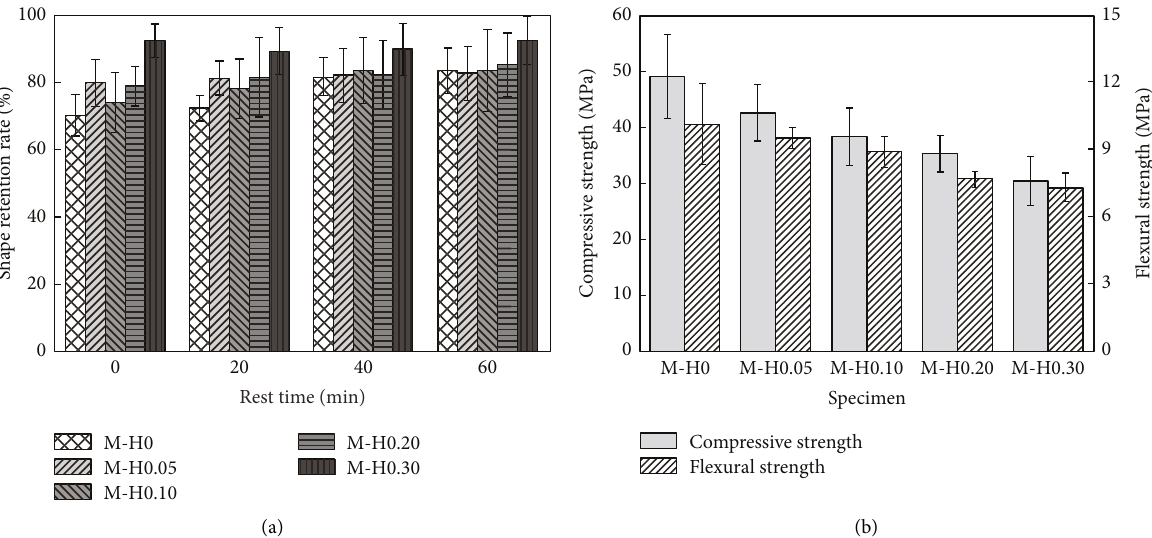
Figure 17: Changes in shape stability (a) and compressive and flexural strength (b) of 3D printing concrete with different HPMC contents